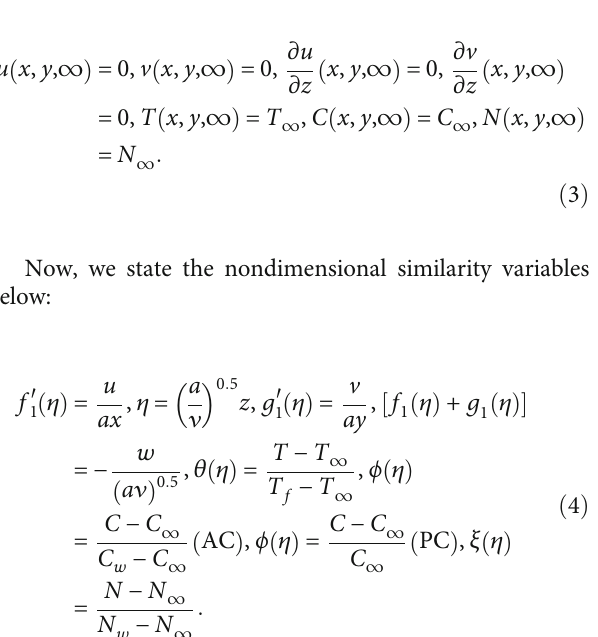
Table 3: Comparison of − f with limiting conditions Q = d